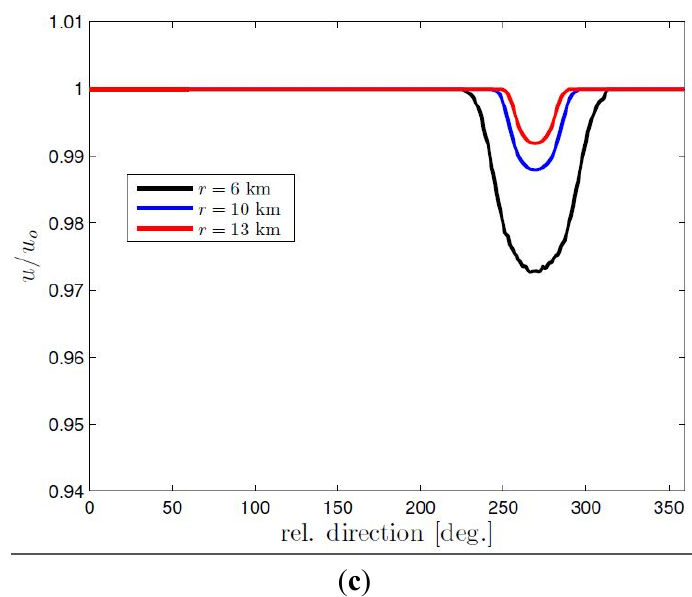
Figure 11. Wake results from the modified PARK model at Horns Rev 1 using wake decay coefficients ( a ) 0.03; ( b ) 0.04 and ( c )